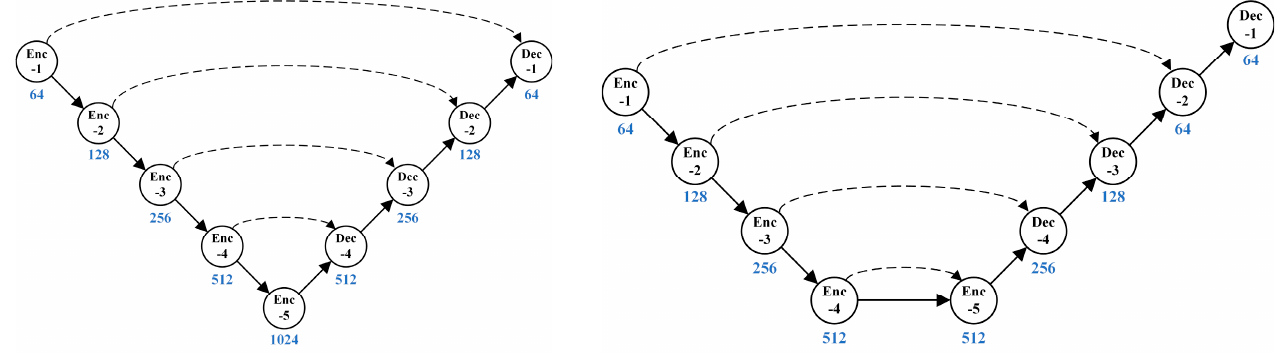
Figure 6. Architecture diagram of UNet and Panoptic - PolarNet; the dotted line refers to the skip